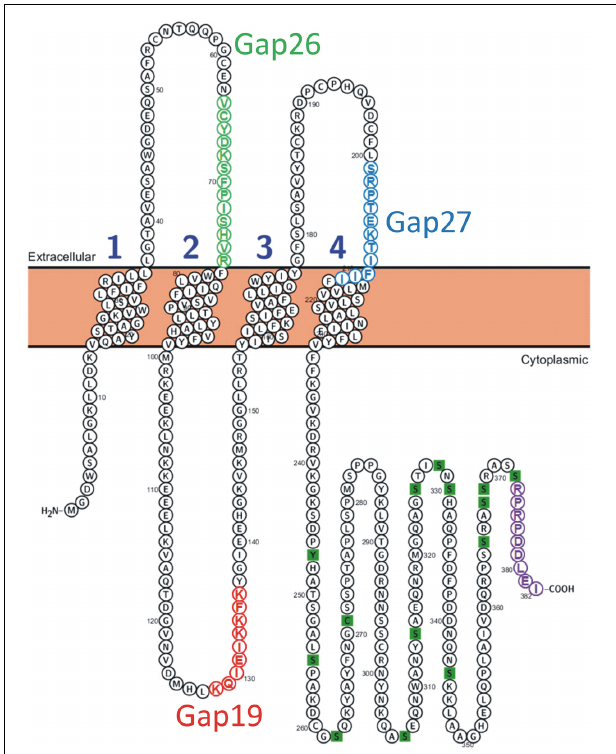
FIGURE 1 | Position of the Gap19 sequence in the intracellular cytoplasmic loop domain of human Cx43. One identified interaction site is located in the last 9 AAs of the CT-tail marked in purple (Wang et al., 2013a). The sequences of Gap19 (red) on the intracellular loop, Gap26 (green) and Gap27 (blue) on the extracellular loops are indicated on the drawing. The CT residues marked as green squares are sites of posttranslational modifications and have been added for illustration purposes [Illustration generated with the Protter tool (Omasits et al.,